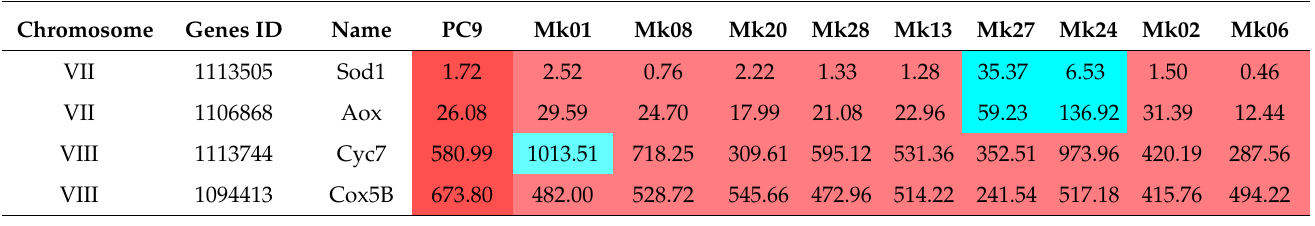
Table 1. Expression profile (RPKM) and parental origin allele of Sod1 , Aox , Cyc7 , and Cox5B genes. RPKMs were retrieved from RNA-seq data. MkPC9 (dark red) and MkPC15 (dark blue) are the parental protoclones. Light red (MkPC9 type) and blue (MkPC15 type) colors in fast- and slow-growing monokaryons indicate the origin of the parental allele in each mono- karyon. Monokaryon growth rates ranged from the fastest to the slowest (indicated by the symbols + and -,